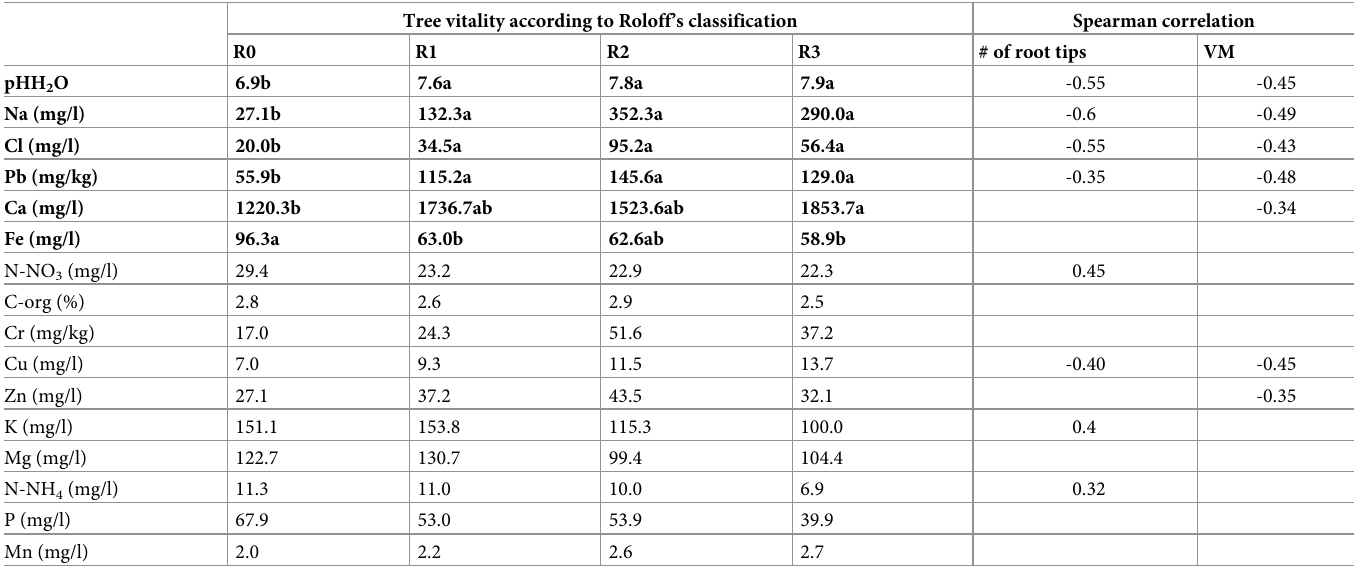
Table 2. Mean values of selected physical and chemical properties of soil in samples associated with the trees of different damage classes. Tree vitality according to Roloff’s